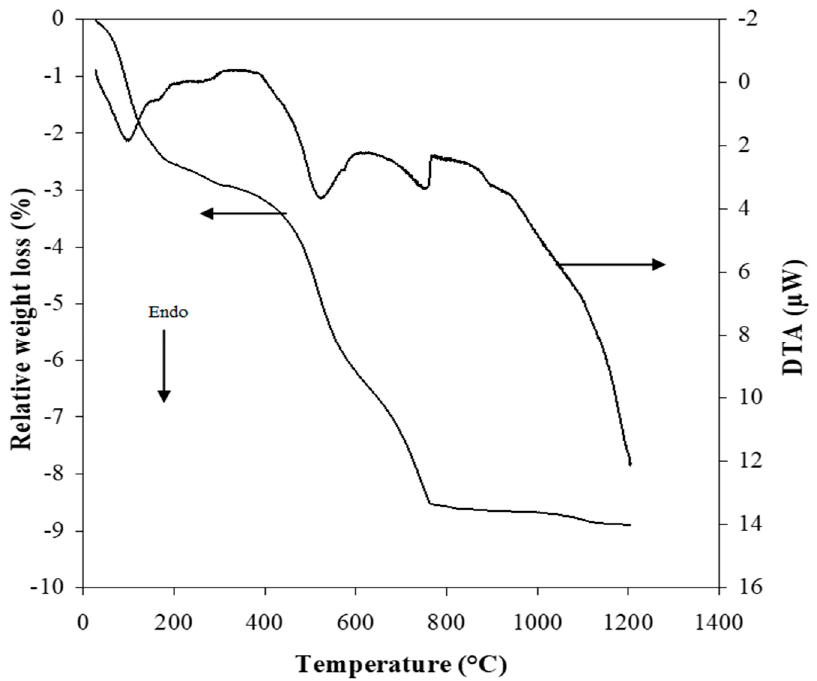
Figure 4. DTA/TGA curves of A25 sample .